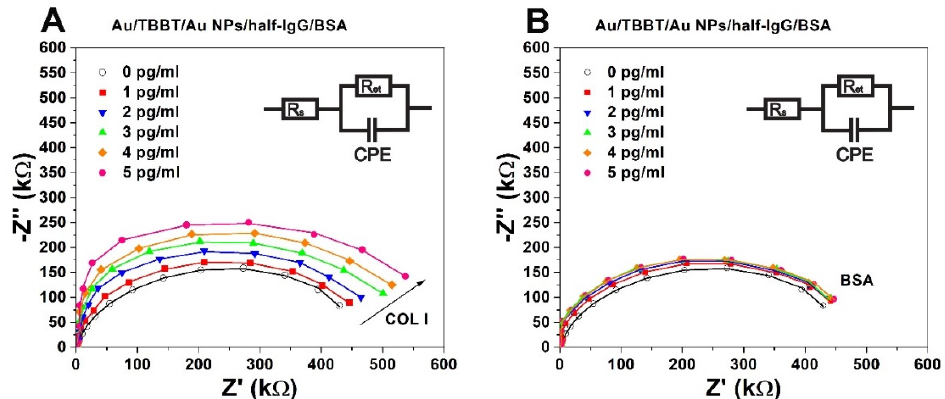
Figure 6. Electrochemical impedance spectra: ( A ) Au/TBBT/AuNPs/half-IgG/BSA in the presence of collagen I, ( B ) Au/TBBT/AuNPs/half-IgG/BSA in the presence of BSA. Concentration range of collagen I analyte: ( ○ ) 0, ( ■ ) 1, ( ▼ ) 2, ( ▲ ) 3, ( ♦ ) 4, ( ● ) 5 pg/mL. Measuring conditions of the EIS: applied frequencies from 0.01 Hz —100 kHz with the bias potential at 0.17 V in 10 mV of ac amplitude. The EIS spectra were fitted to the Nyquist plots for an electrical circuit model, which included R s —solution resistance, R et —electron transfer resistance, and CPE—constant phase element. Composition of the used electrolyte: 0.1 M PBS, pH 7.4 with 0.5 mM K 3 [Fe (CN) 6 ]/K 4 [Fe (CN) 6 ] (1:1).